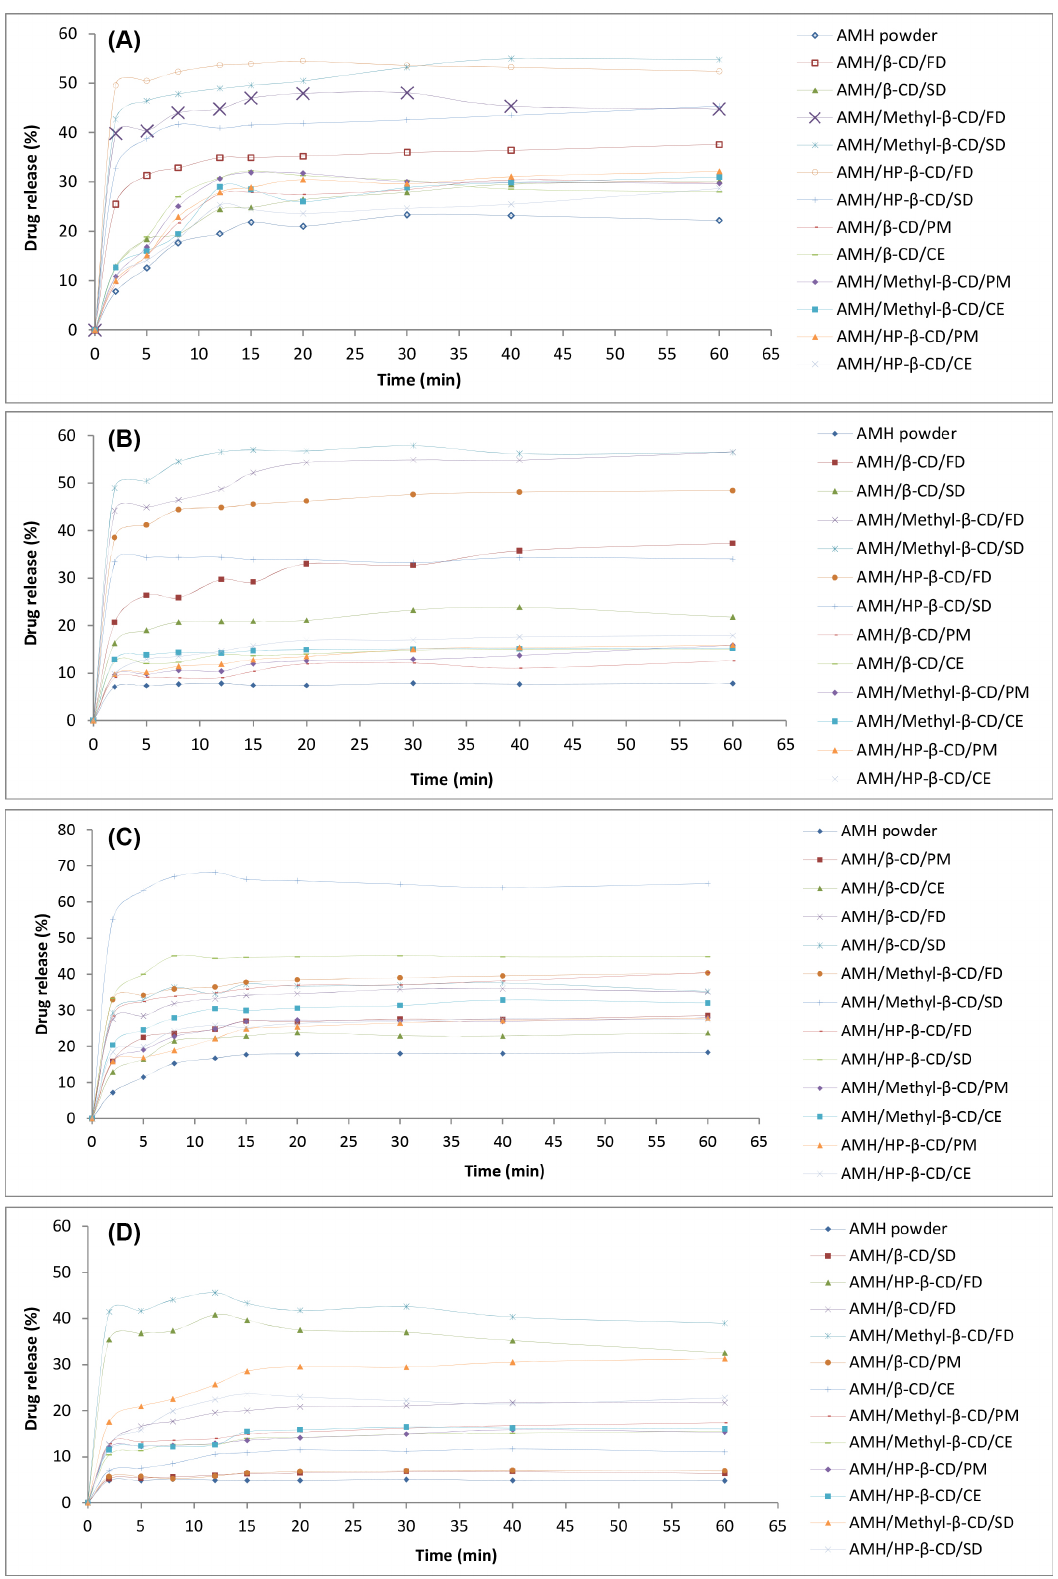
FIGURE 5 - Dissolution curves of AMH powder and different formulations using: (A) water, (B) acid buffer pH 1.2, (C) acetate buffer pH 4.5 and (D) phosphate buffer pH 6.8 as dissolution medium at 37 ºC ± 0.5